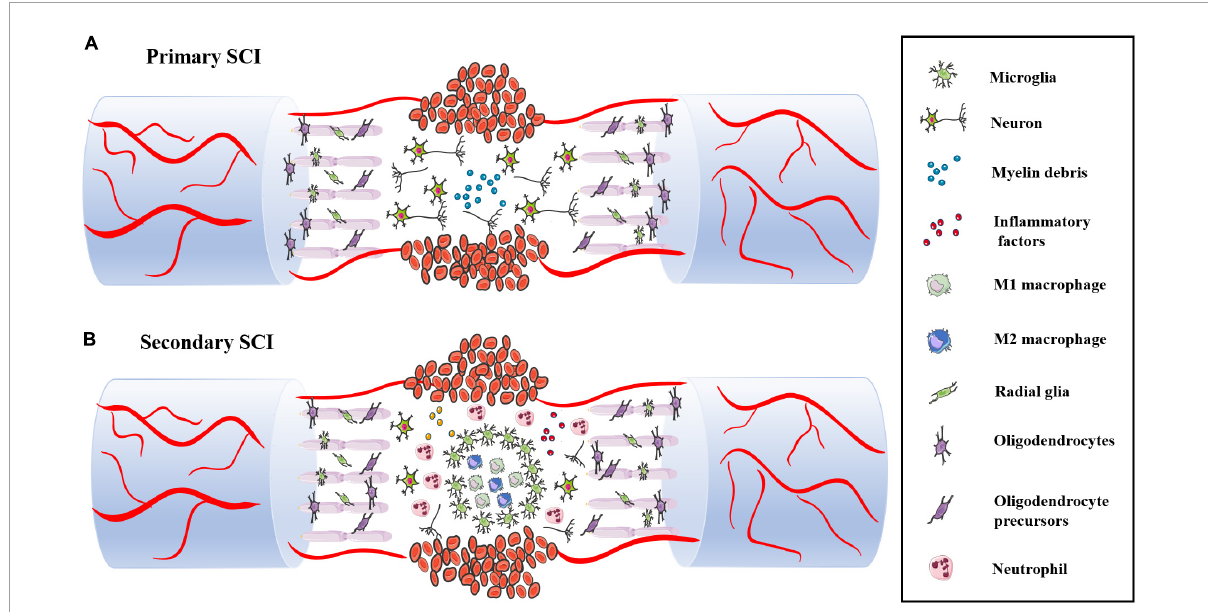
FIGURE3 (A) The structure and content of spinal cord are destroyed during primary SCI, including neuron body and axon damage and destruction of the BSCB. (B) Following SCI, immune cells infiltrate into the damaged spinal cord and release various pro-inflammatory factors, which leads to massive neuronal